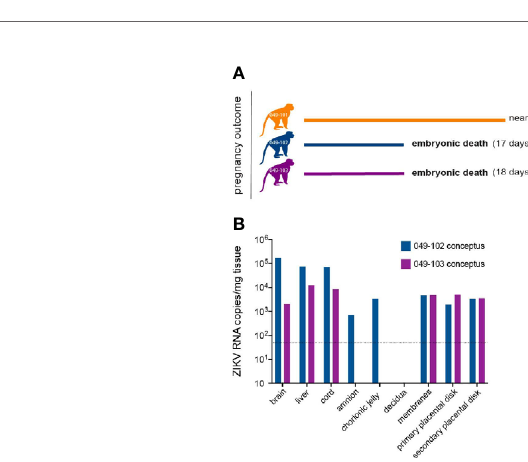
FIGURE 3 | Pregnancy outcomes and maternal-fetal interface (MFI) and fetal tissue vRNA loads. (A) Pregnancy outcomes for three dams intravaginally inoculated 3x with ZIKV at approximately 30 days gestation. Two dams (049-102 and 049-103) were determined by ultrasound to have nonviable embryos at approximately 17-18 days post-ZIKV challenge. Hysterotomies and embryo and MFI tissue collections were performed 3 days after detection. Dam 049-101 ’ s pregnancy continued until scheduled hysterotomy and extensive tissue collection at approximately 155 days gestational age. (B) Average ZIKV vRNA loads for positive embryo and MFI tissues collected at hysterotomy from dams 049-102 (blue) and 049-103 (magenta) following embryonic death at approximately 17-18 days post-ZIKV challenge. The dashed line represents the average of the estimated limit of detection (50-100 copies/mg, average: 75 copies/mg tissue) for the qRT-PCR assay. (C) Average ZIKV vRNA loads for positive MFI tissues collected at hysterotomy from dam 049-101 (orange) at approximately 122 days post-ZIKV infection. Fetal tissues were negative for ZIKV RNA by qRT-PCR. The dashed line represents the average of the estimated limit of detection (50-100 copies/mg, average: 75 copies/mg tissue) for the qRT-PCR assay.